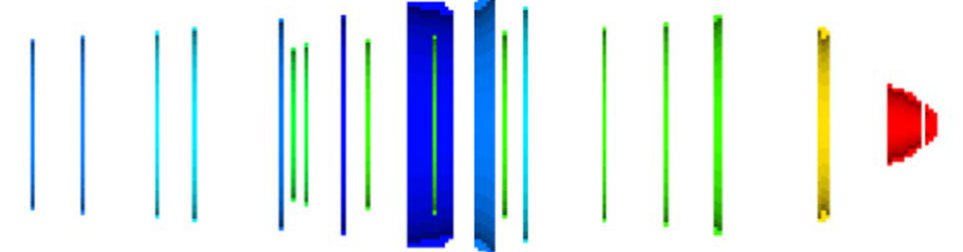
Figure 23. Copper penetrator shape (Autodyn); after 65 µs - liner thickness is variable (1 mm center, 2 mm periphery) [8]